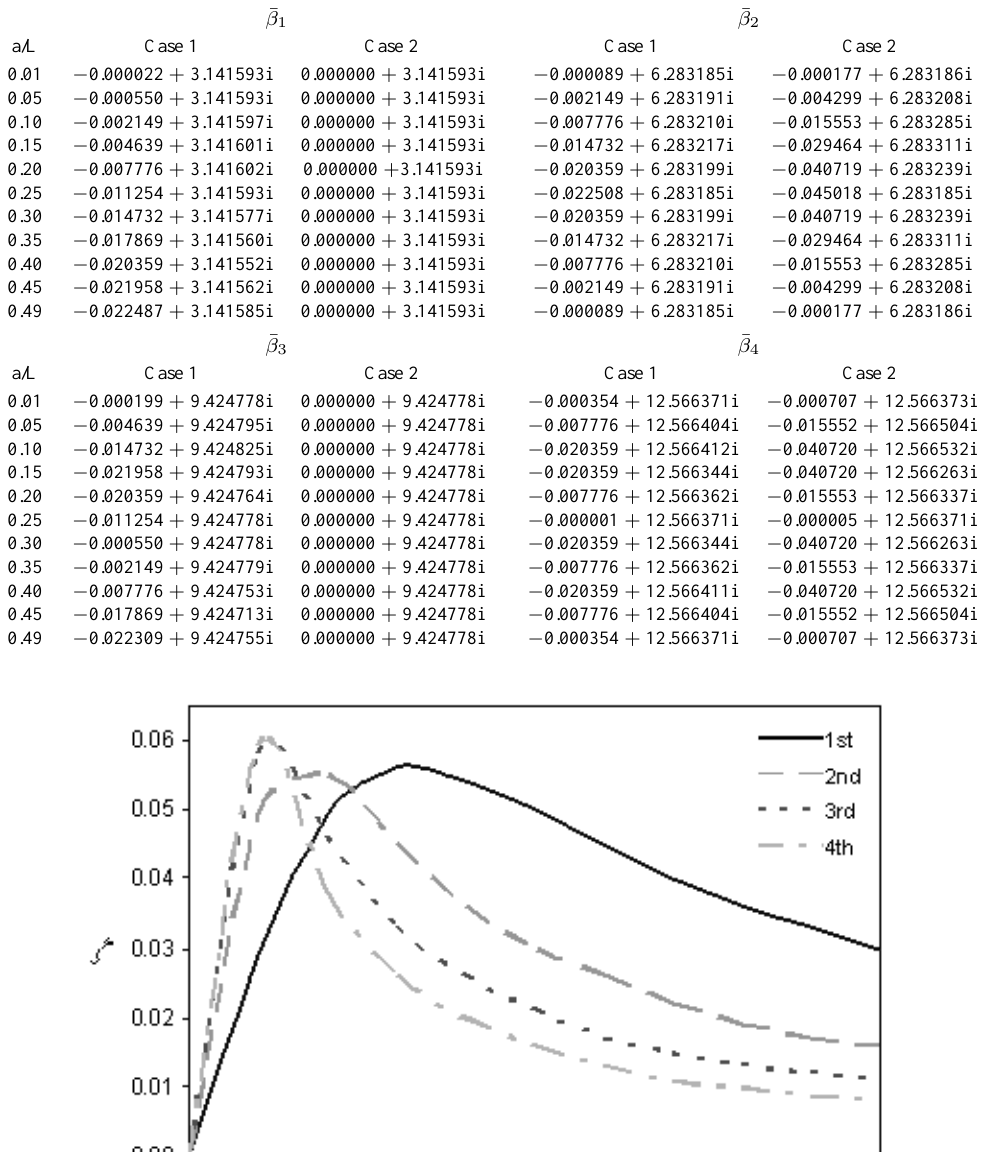
Table 1 First four dimensionless eigenfrequencies of the locally (Case 1) and non-locally (Case 2) damped elastic rod